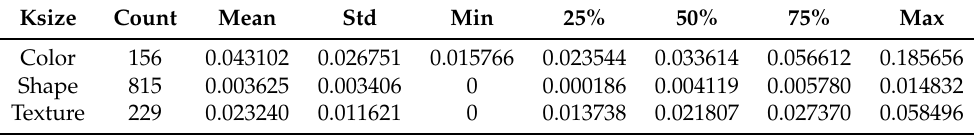
Figure 14. The boxplot for the five most important feature types in different images. The top five important features all come from color features, this also shows that the color feature is the most important among the three types of features. Table 3. Statistics for different feature types generated according to the boxplot in Figure